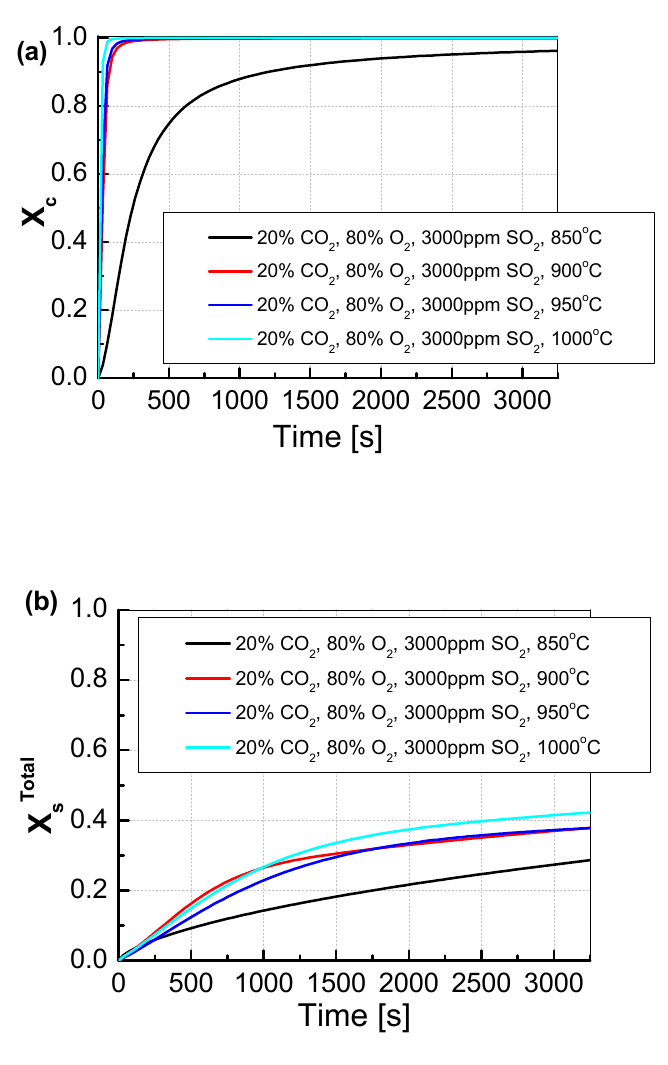
Figure 7. Comparison of the results of approximation of ( a ) the degree of calcination X c and ( b ) the total degree of X s Total sulfation determined depending on the volume fraction of CO 2 in synthetic exhaust containing 20% CO 2 and 3000 ppm SO 2.